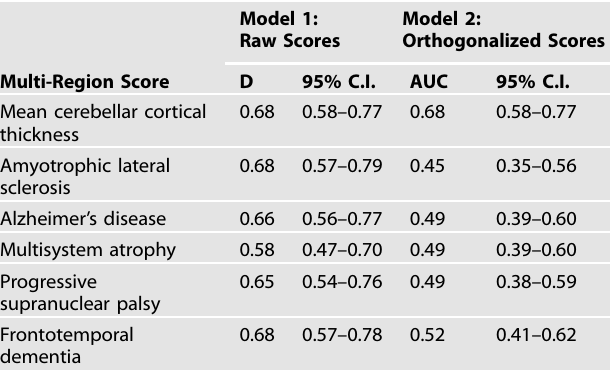
Table 3. Diagnostic grouping as de fi ned by regional differences in cerebellar atrophy.